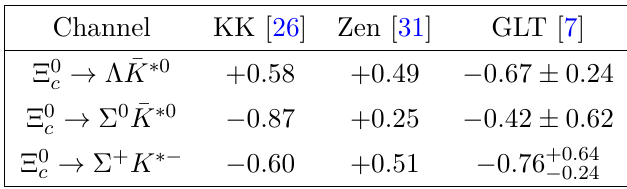
Table 2 . The asymmetry parameters for the Cabibbo-favored Ξ 0 covariant quark model from KK [26], pole model from Zen [31], and SU(3) F flavor symmetry from GLT